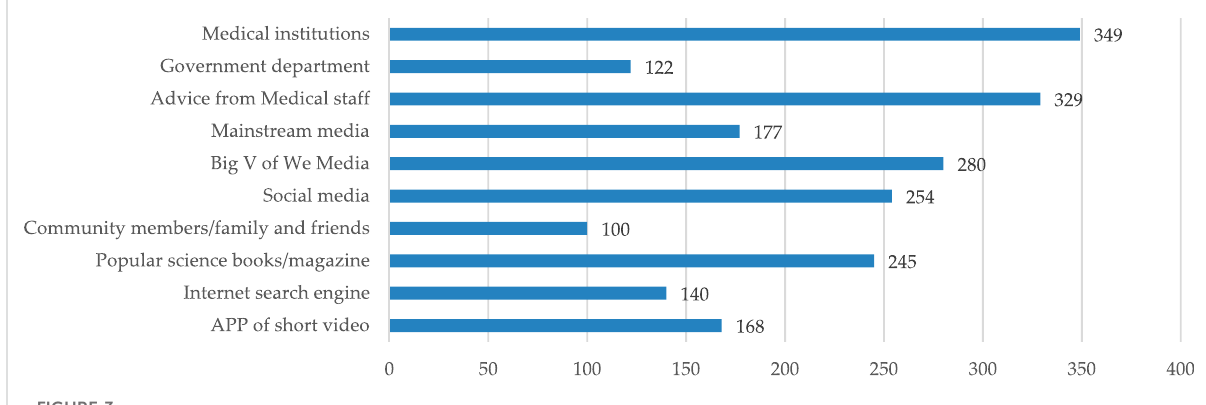
FIGURE 3 Access to healthcare science education regarding the safe usage of children ’ s